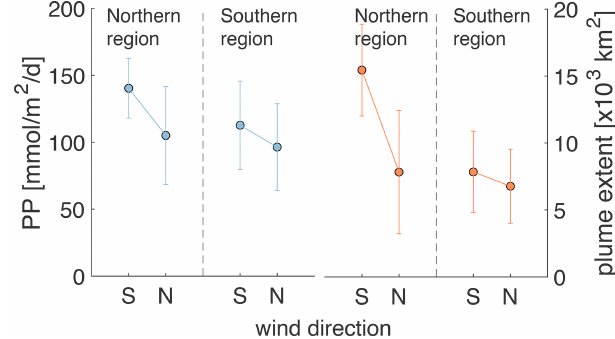
Figure 8. Mean PP and FW plume extent in the northern and south- ern regions averaged over all days during the 6-year simulation with north and south wind (i.e., when direction is ± 45 ◦ of true north or south) and wind strength > 0.03Pa in